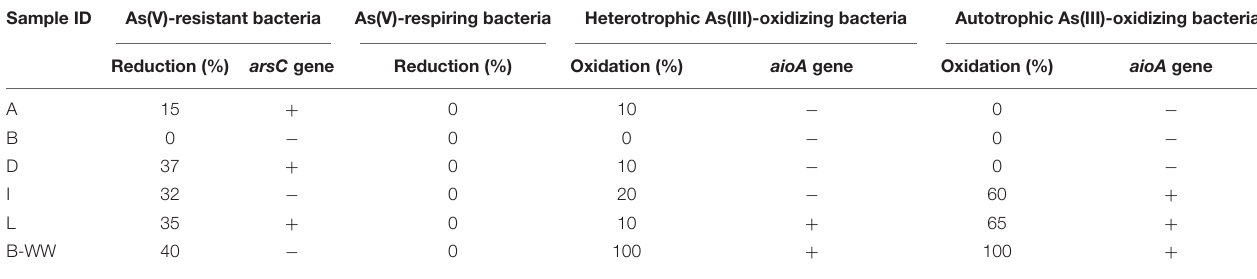
TABLE 3 | Percentage (%) of arsenic transformation in the enrichment cultures. Sample